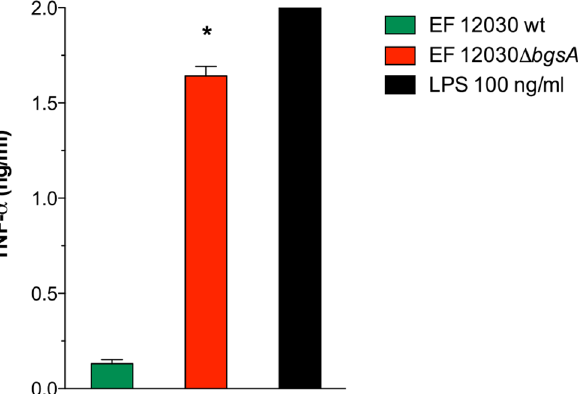
Fig 3. Stimulation of TNF- α production in RAW 264.7 mouse macrophages by lipoprotein-enriched cell membrane fractions of E . faecalis wild type and Δ bgsA . RAW 264.7 cells were incubated with lipoprotein- enriched Triton X-114 extracts from total membrane protein fractions derived from the indicated E . faecalis strains. The concentration of lipoprotein extracts was measured photometrically and normalized to a bacterial cfu:RAW 264.7 cell ratio of 10,000:1. At 16 h, supernatants were collected and TNF- α concentrations were quantified by ELISA. LPS at a concentration of 100 ng/ml was used as positive control. Data